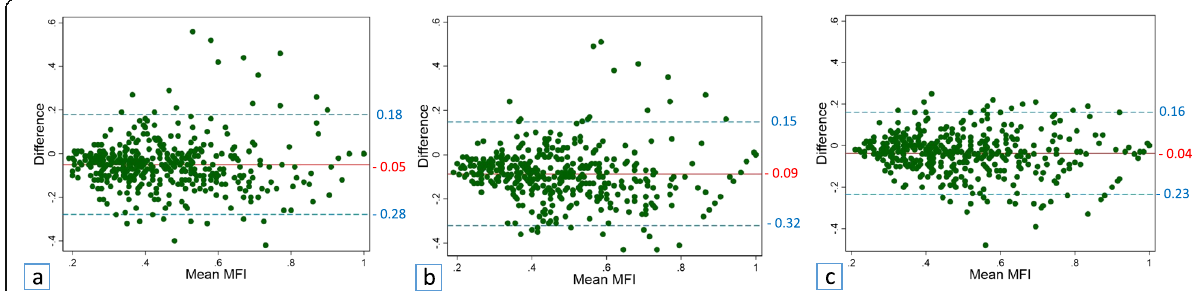
Fig. 3 Bland-Altman plots with mean differences in measurements of the muscle fat index (MFI, solid lines) and 95% limits of agreement (dashed lines) between observers 1 and 2 ( a ), observers 1 and 3 ( b ), and observers 2 and 3 ( c